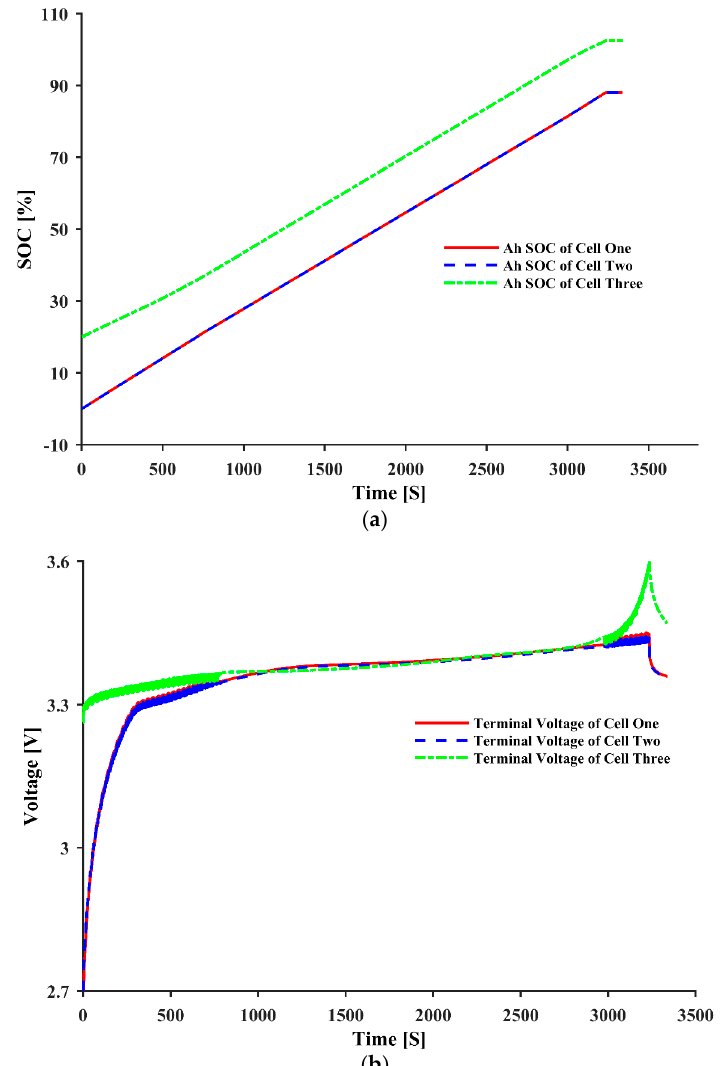
Figure 8. Pack balancing performance in the charging process with terminal voltage as balancing criterion. ( a ) Experimental results for Coulomb counting SOCs of three cells during charging process; ( b ) experimental results for terminal voltages of three cells during charging process.